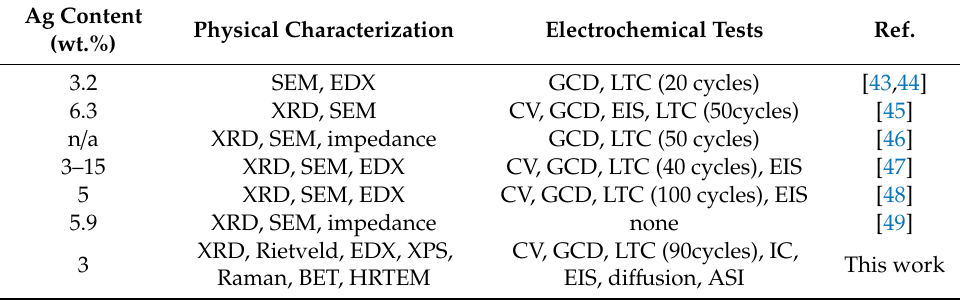
Table 1. List of investigations carried out on Ag-coated LMO cathode materials from the literature. Ag Content Physical (wt.%)